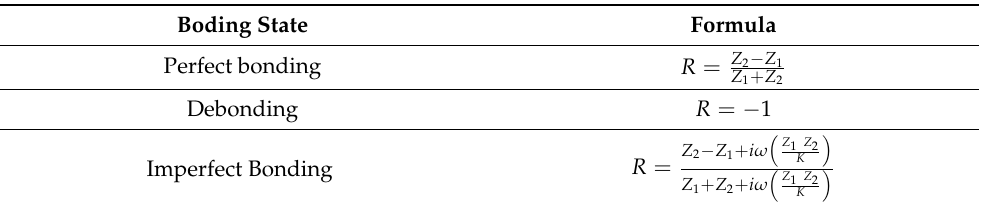
Table 1. Reflection coefficient of the waveform for bonded, debonded, and partial or imperfect bonding